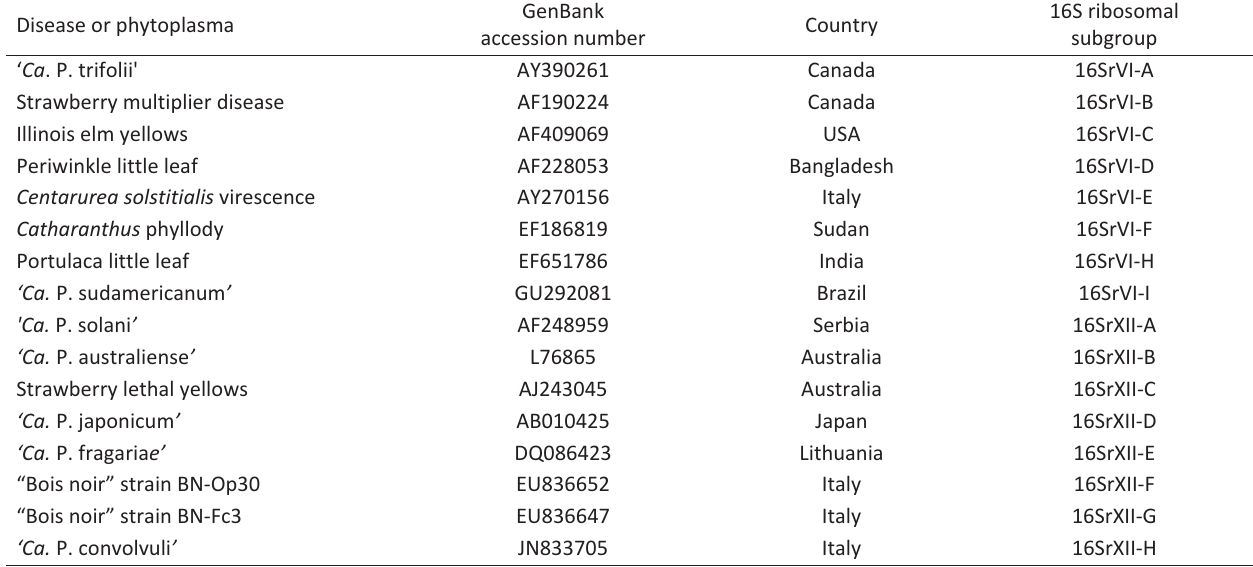
Table 1 ­ Phytoplasma sequences used for comparison with the reported greenhouse cucumber strains from Iran Disease or phytoplasma